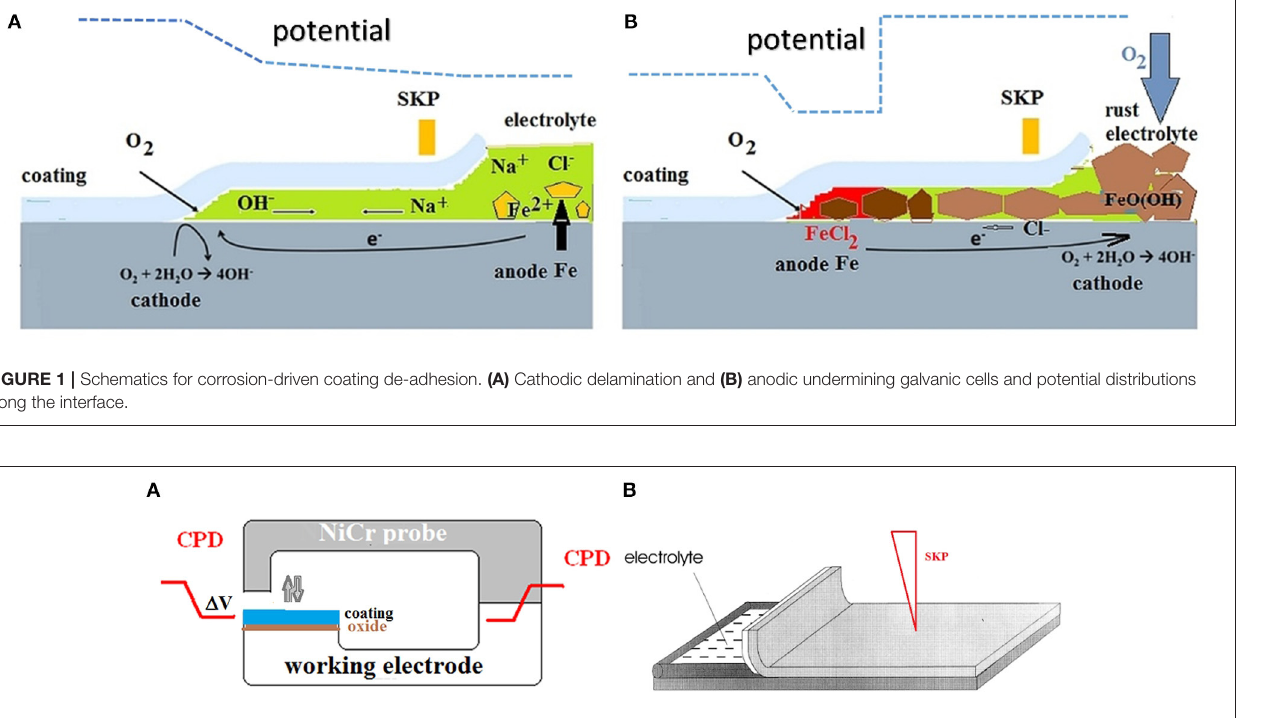
FIGURE 2 | Schematic of the Kelvin Probe (A) and the sketch of the sample for evaluation of cathodic delamination of a polymeric coating (B) .